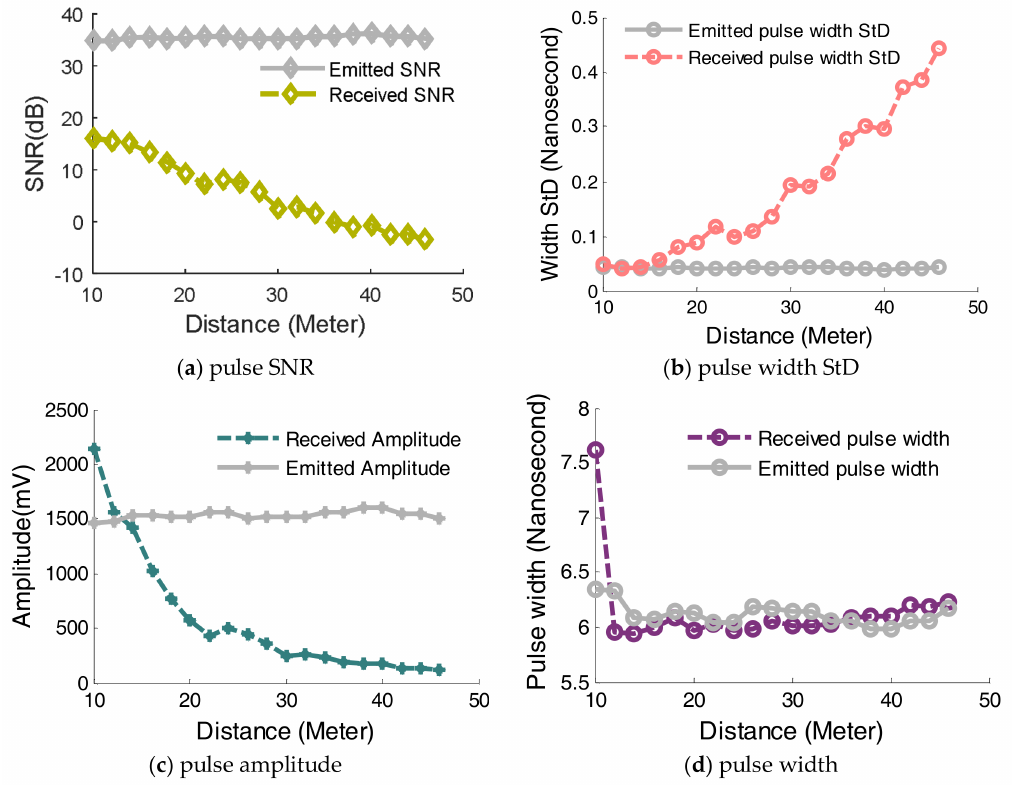
Figure 7. Waveform characteristics varying with range